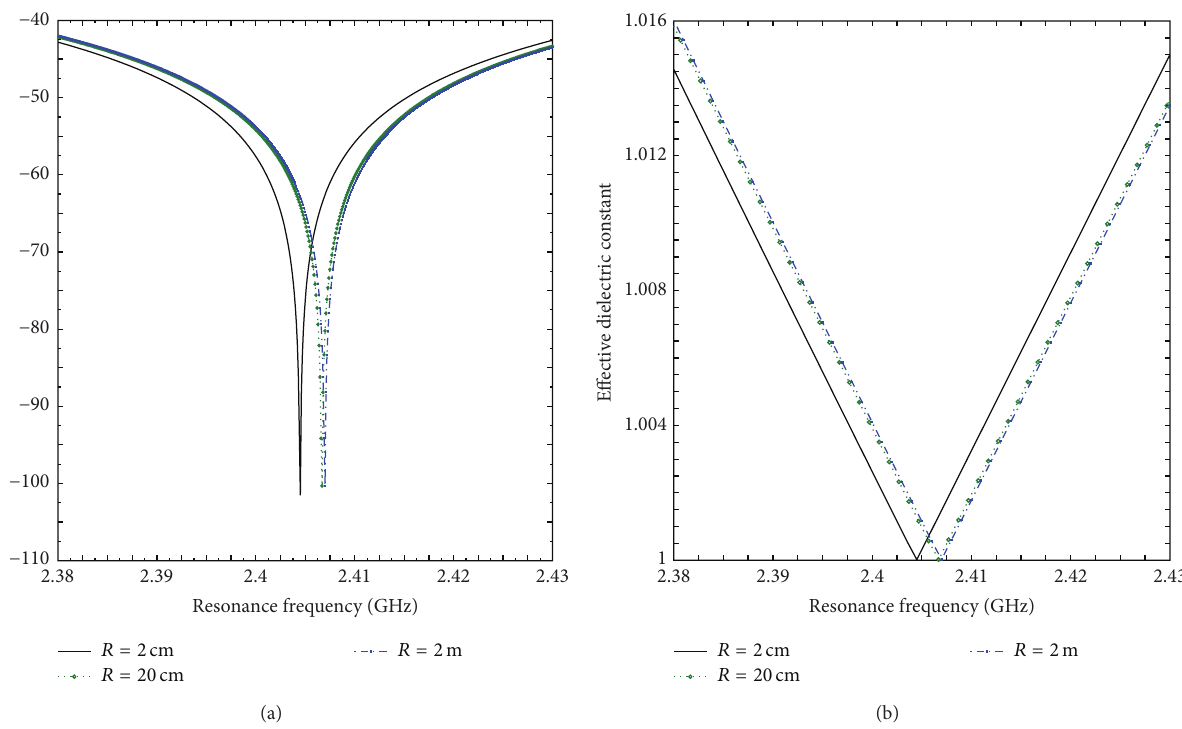
Figure 6: Impact of changing radius of curvature (2cm, 20 cm, and 2 m) of a circular microstrip patch (a) on the return loss in dB and (b) on the VSWR as a function of frequency. “Epsilam-10 ceramic-filled Teflon